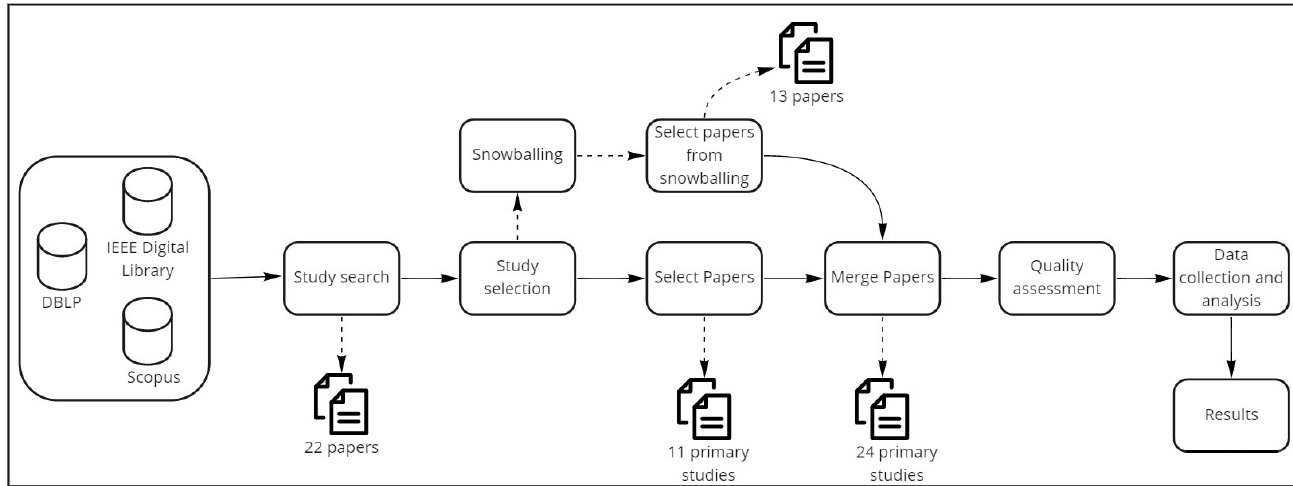
Figure 1. Protocol application